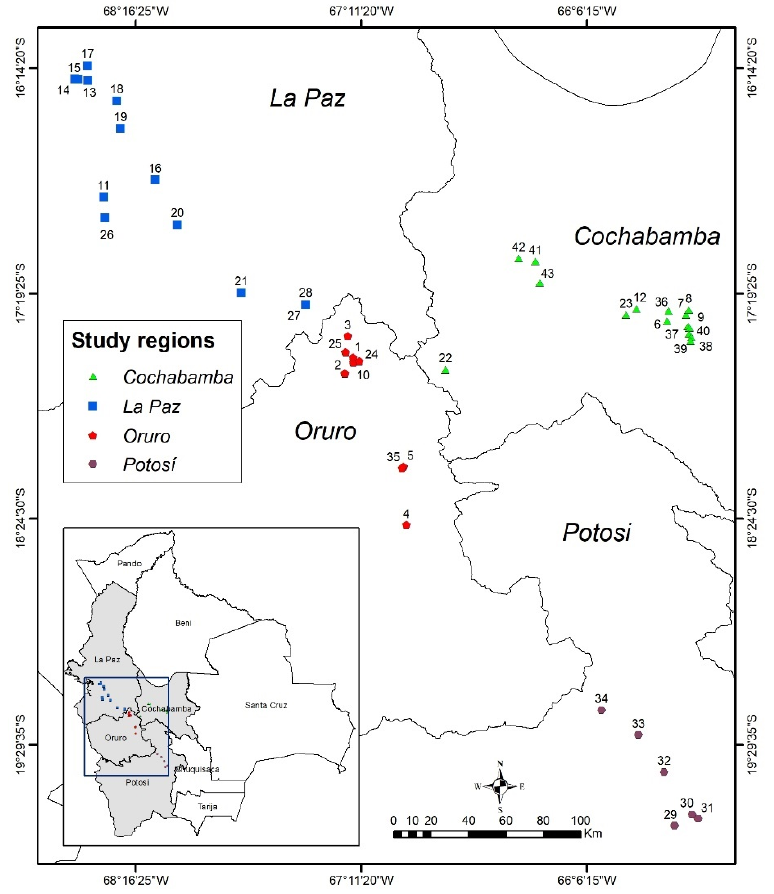
Figure 1. The map of Bolivia (bottom left) and its four departments showing locations where the 43 fescue populations analyzed in this study were collected.